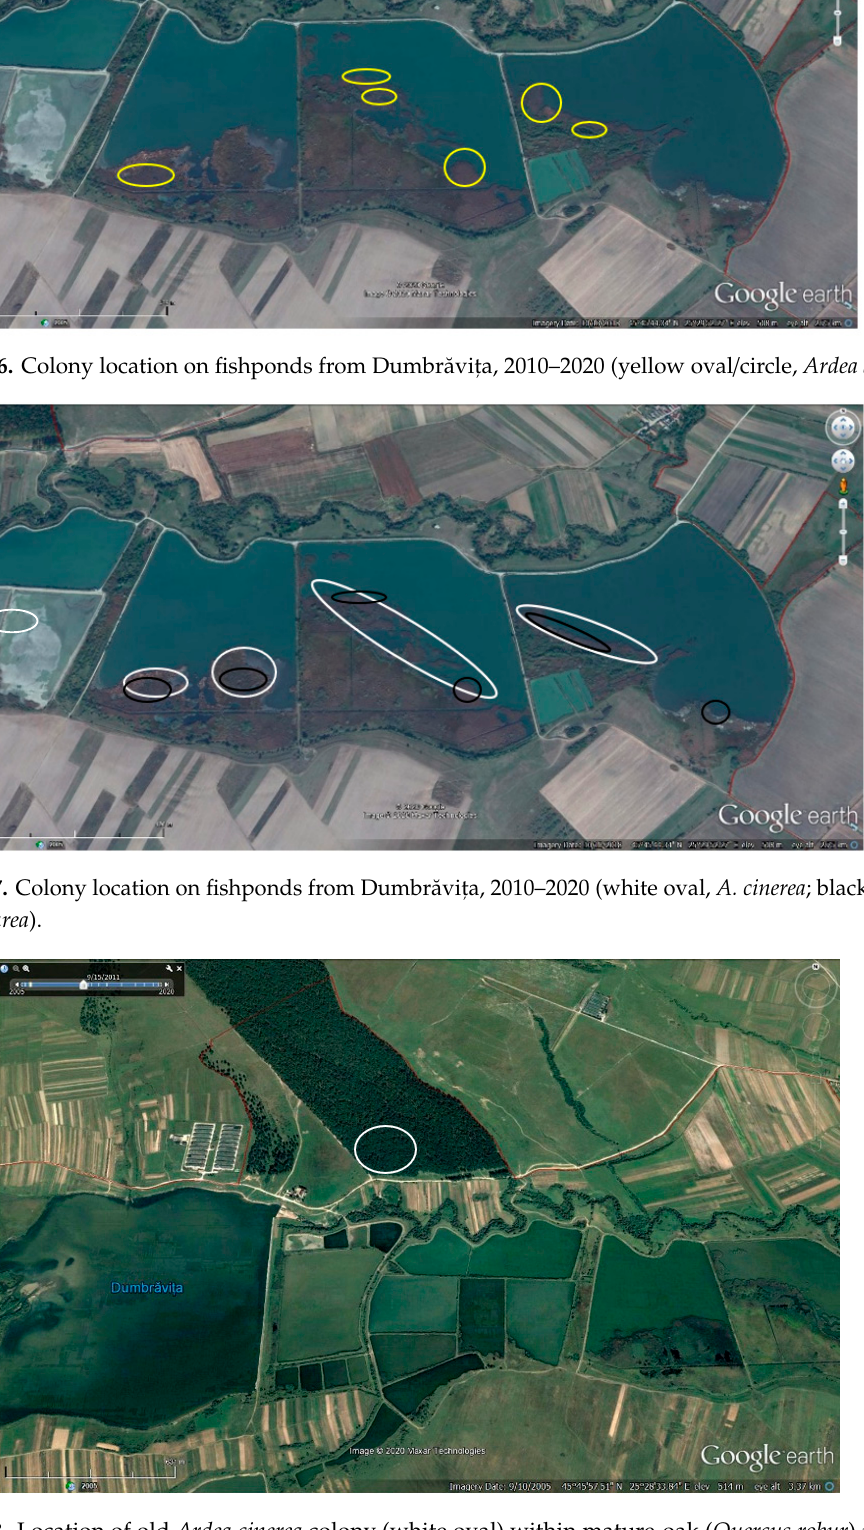
Figure 8. Location of old Ardea cinerea colony (white oval) within mature-oak ( Quercus robur ) forest from Dumbr ă vi ț a; 2011 was the last year when this species bred within the forest.